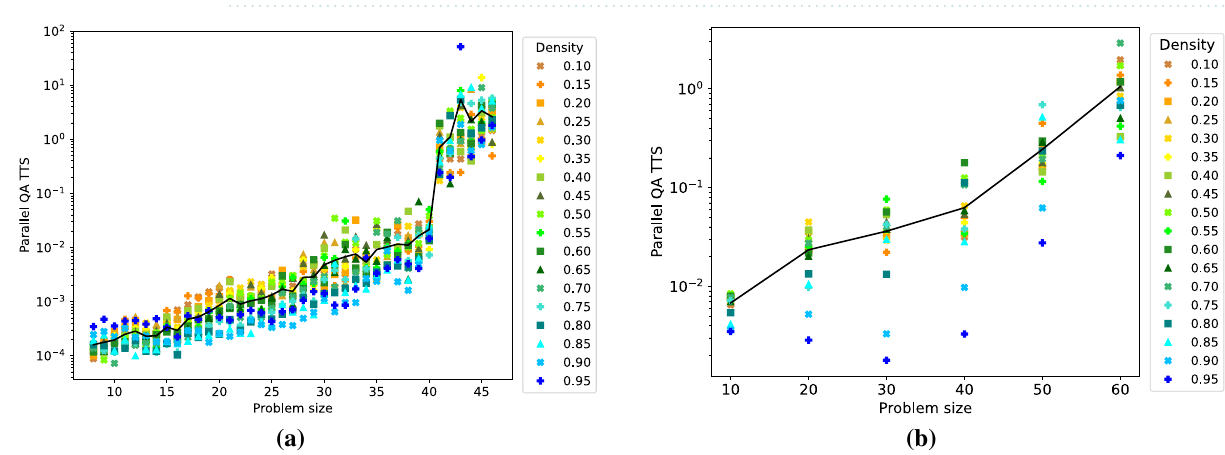
Figure 2. Ground state probability (GSP) achieved by parallel quantum annealing for DW 2000Q ( a ) and for DW Advantage ( b ) as a function of the problem size N . Graph densities range from 0.10 to 0.95 (color coding shown in the legend). Black solid line plots the mean parallel quantum annealing GSP as a function of problem size.